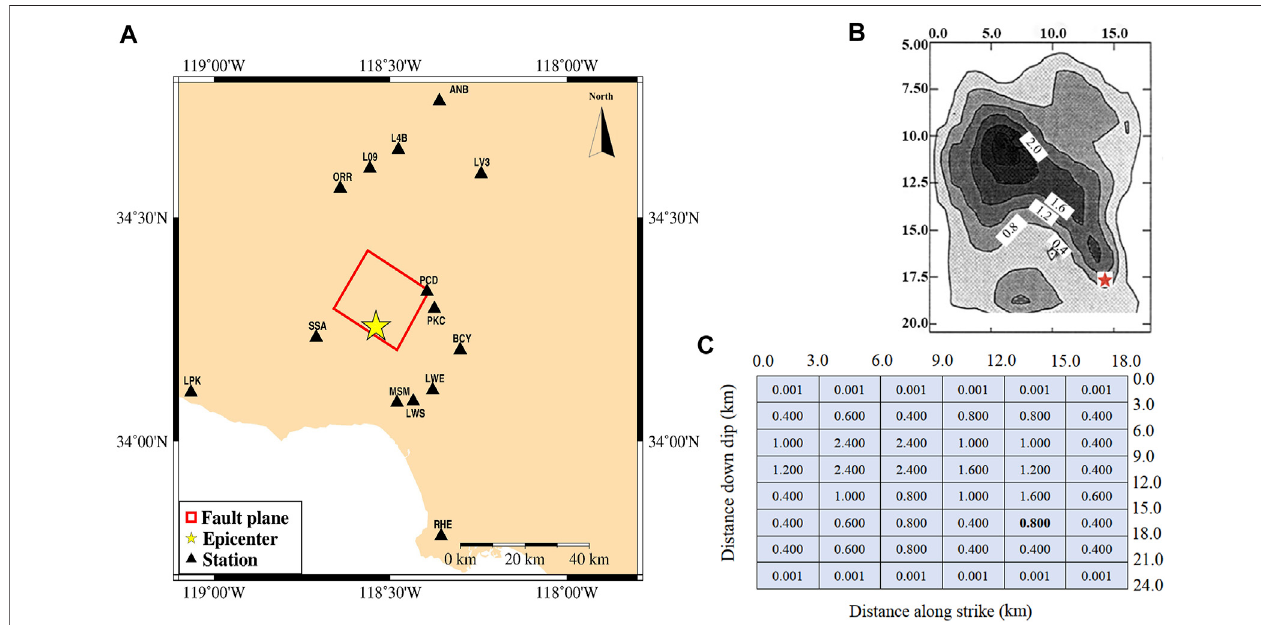
FIGURE 3 | (A) : Distribution of observation stations for the strong ground motion of the Northridge earthquake. The black triangle is the station triggered by the earthquake, and the red rectangle is the horizontal project of the fault; (B) : source model of the Northridge earthquake (Wald et al., 1996; Sun, 2010; Dang et al., 2020); (C) : slip amount of each subfault in the Northridge earthquake (Sun, 2010; Dang et al., 2020). The red star represents the hypocenter.